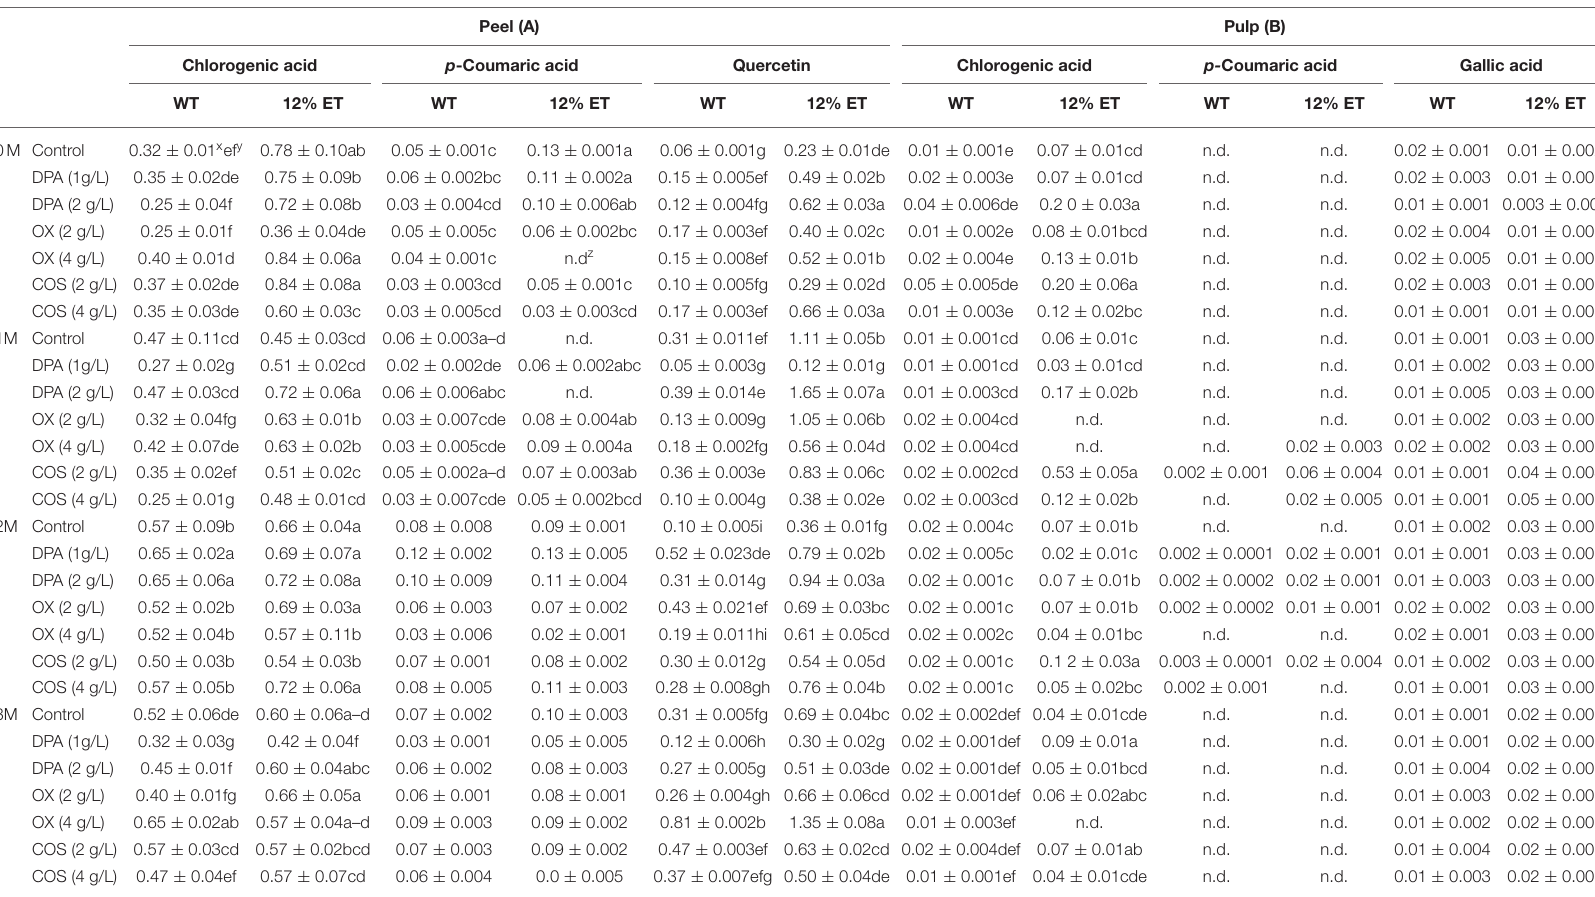
TABLE 1 | Phenolic compound profile ( µ g/g Fresh Weight) of aqueous (WT) and ethanol (12%ET) extracts of Cortland apple peel (A) and pulp (B) with elicitor treatments (DPA, OX, and COS) during 3 months of storage.